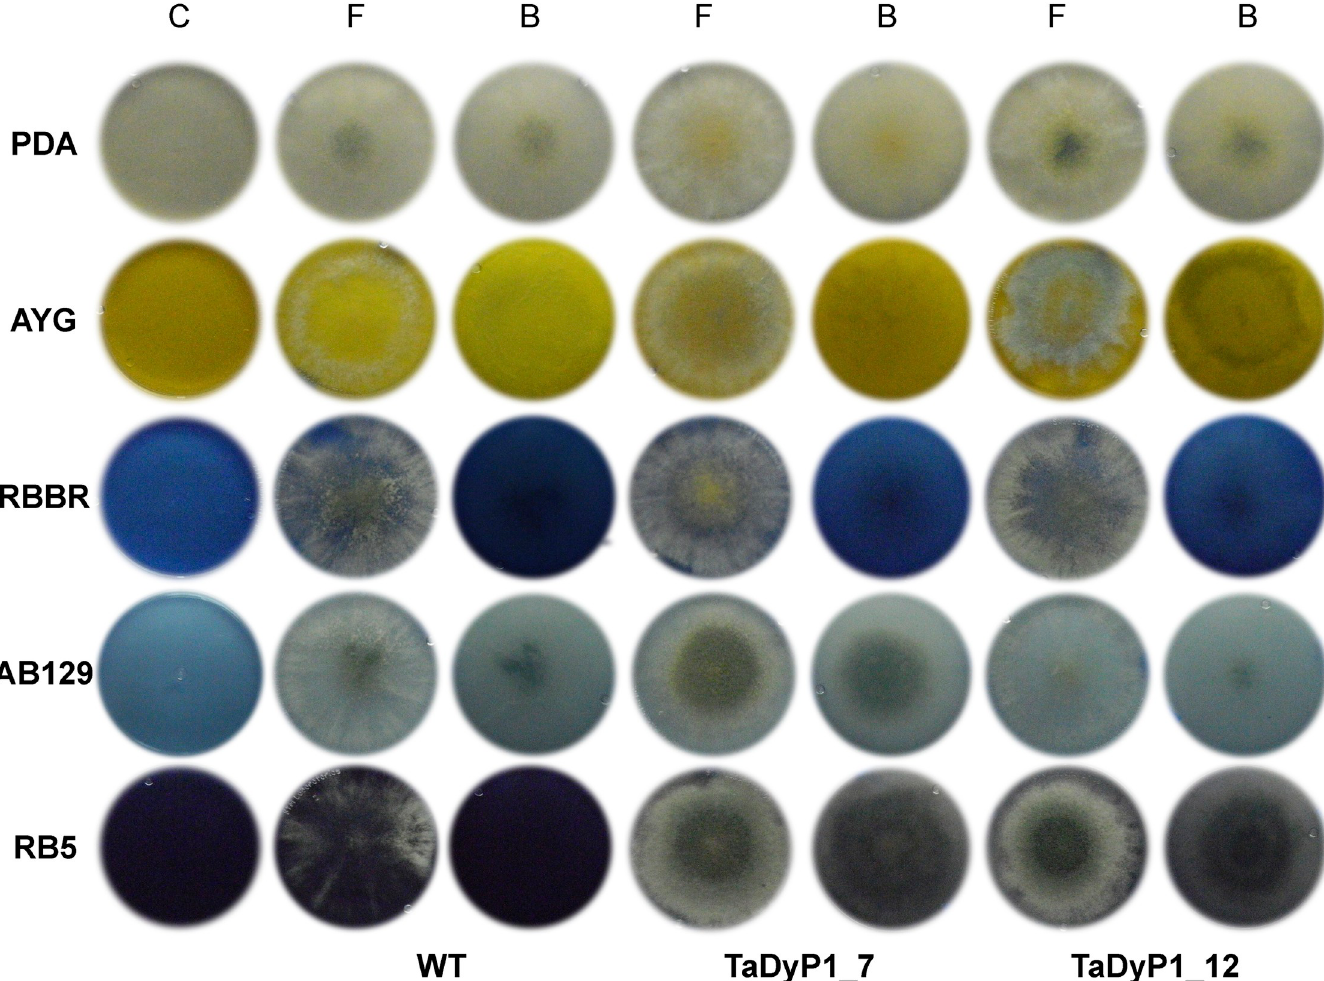
Fig 4. Decolorization of synthetic dyes by T . atroviride transformants. The over-expressing Pleos-DyP1 strains selected were grown on PDA in the presence of 100 ppm of AYG, RBBR, AB129 or RB5 dyes at 28˚C for 96 h. Wild-type (WT) , T . atroviride transformants (TaDyP1_7 and TaDyp1_12) , control without inoculum (C) , petri dish front (F) , petri dish back (B) .